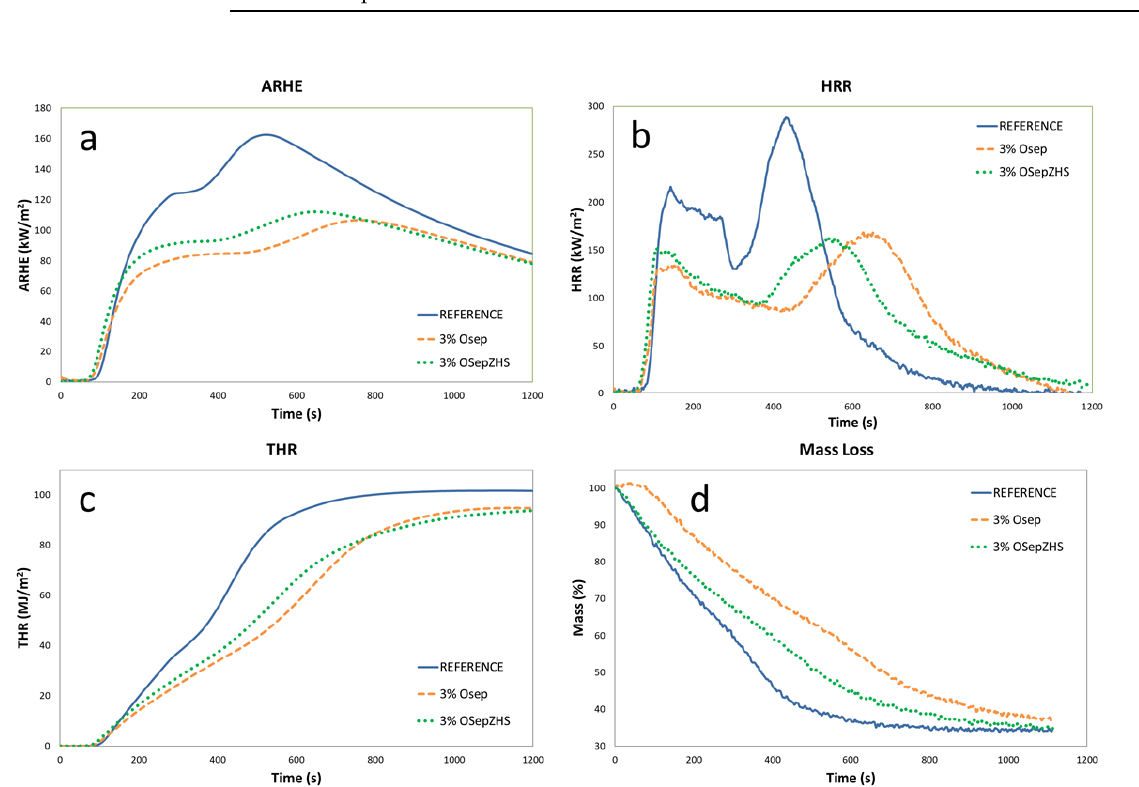
Figure 9. Cone calorimeter results: ( a ) ARHE, ( b ) HRR, ( c ) THR, and ( d ) Mass Loss curves.